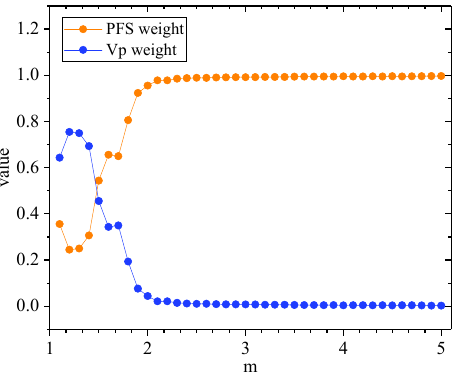
Figure 6. The weight of the two indicators under different values of m